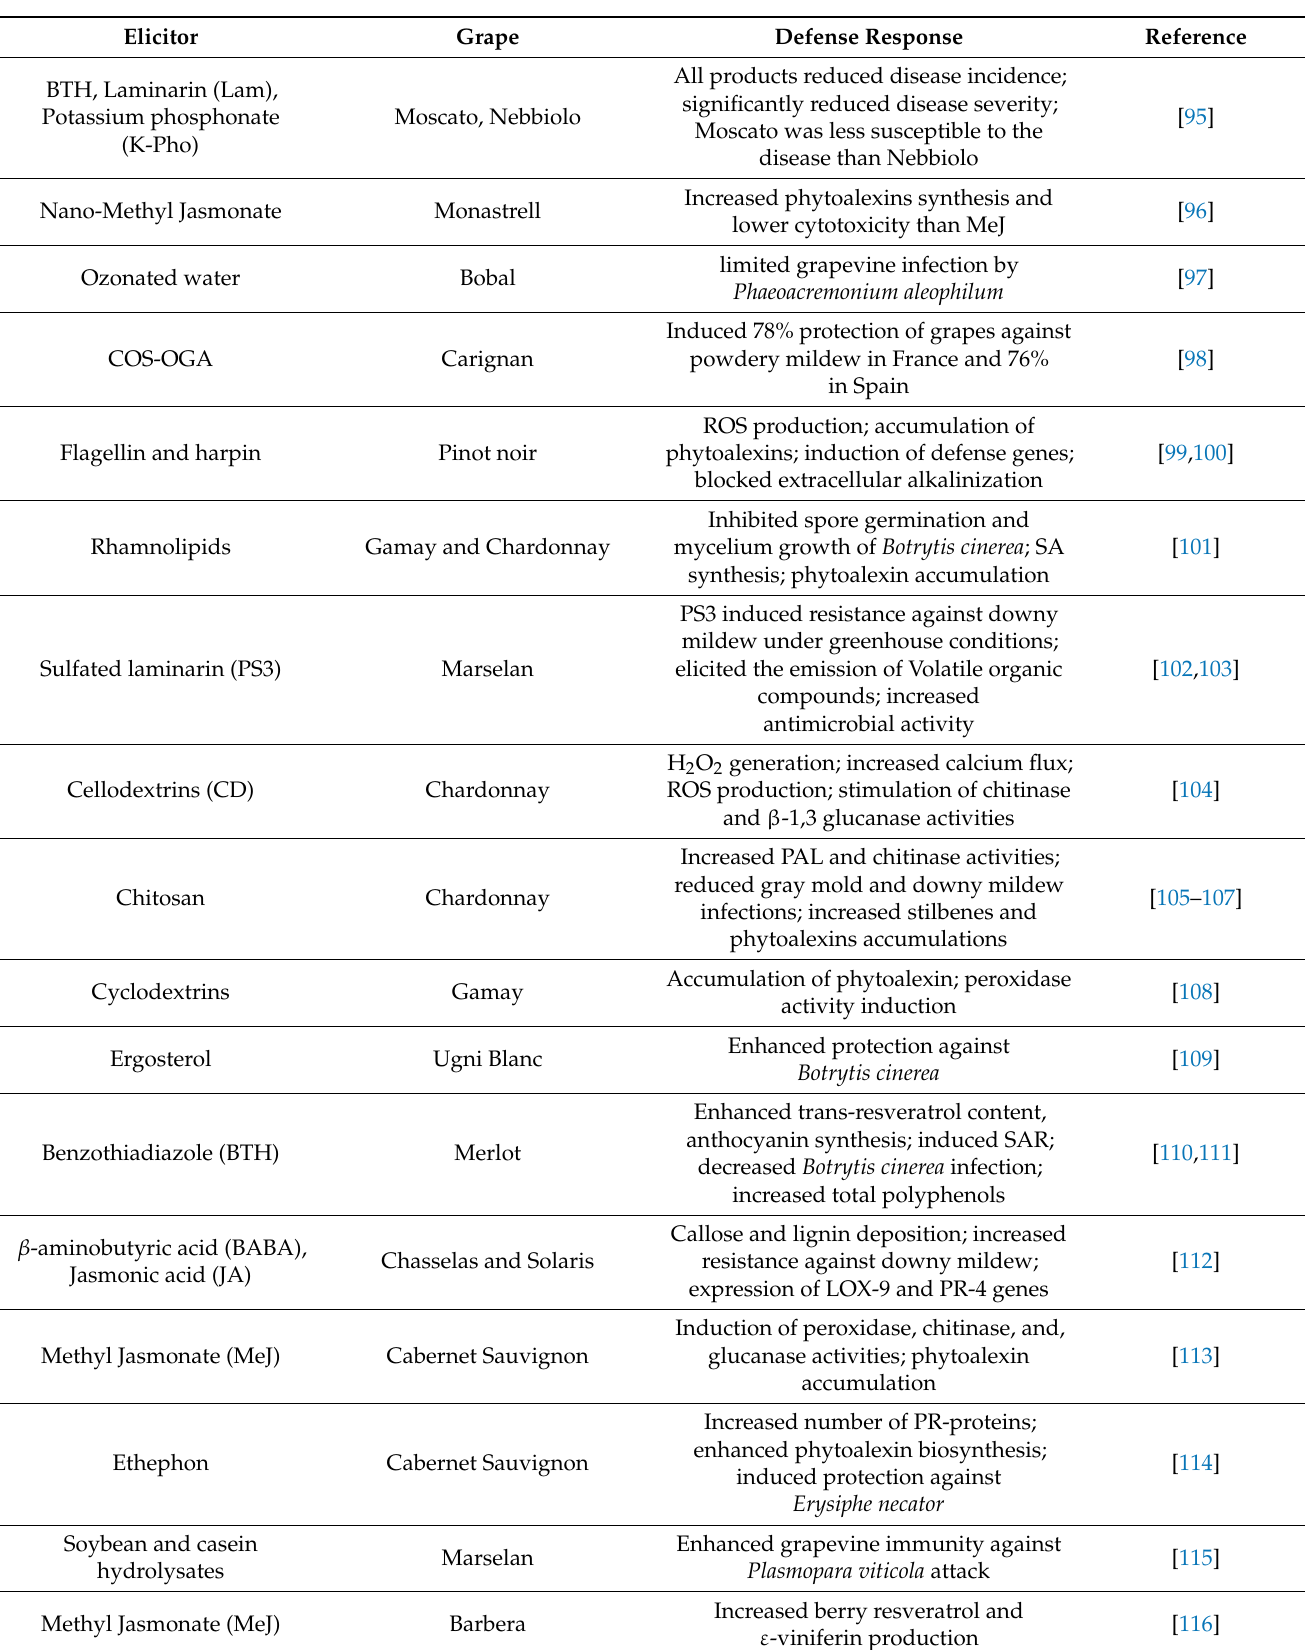
Table 1. List of Some Elicitors and their Defense Impact on Different Grape